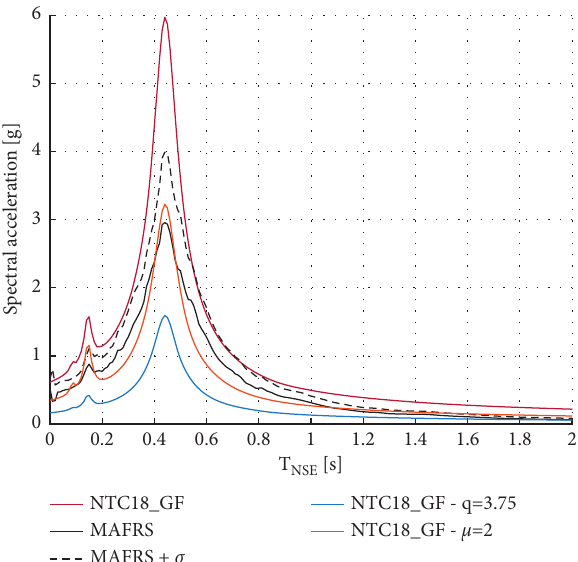
Figure 10: Comparison between NTC18_GF and overdamped